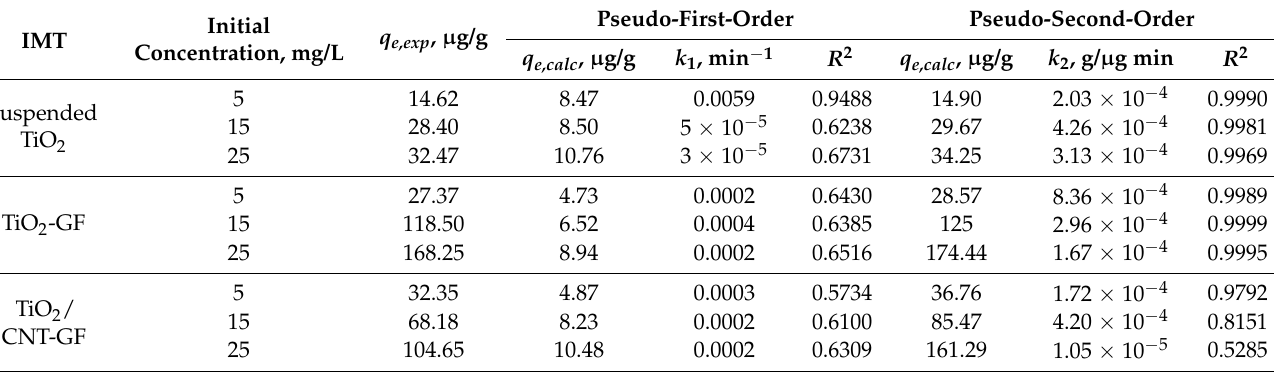
Table 2. Sorption kinetic parameters for IMT.